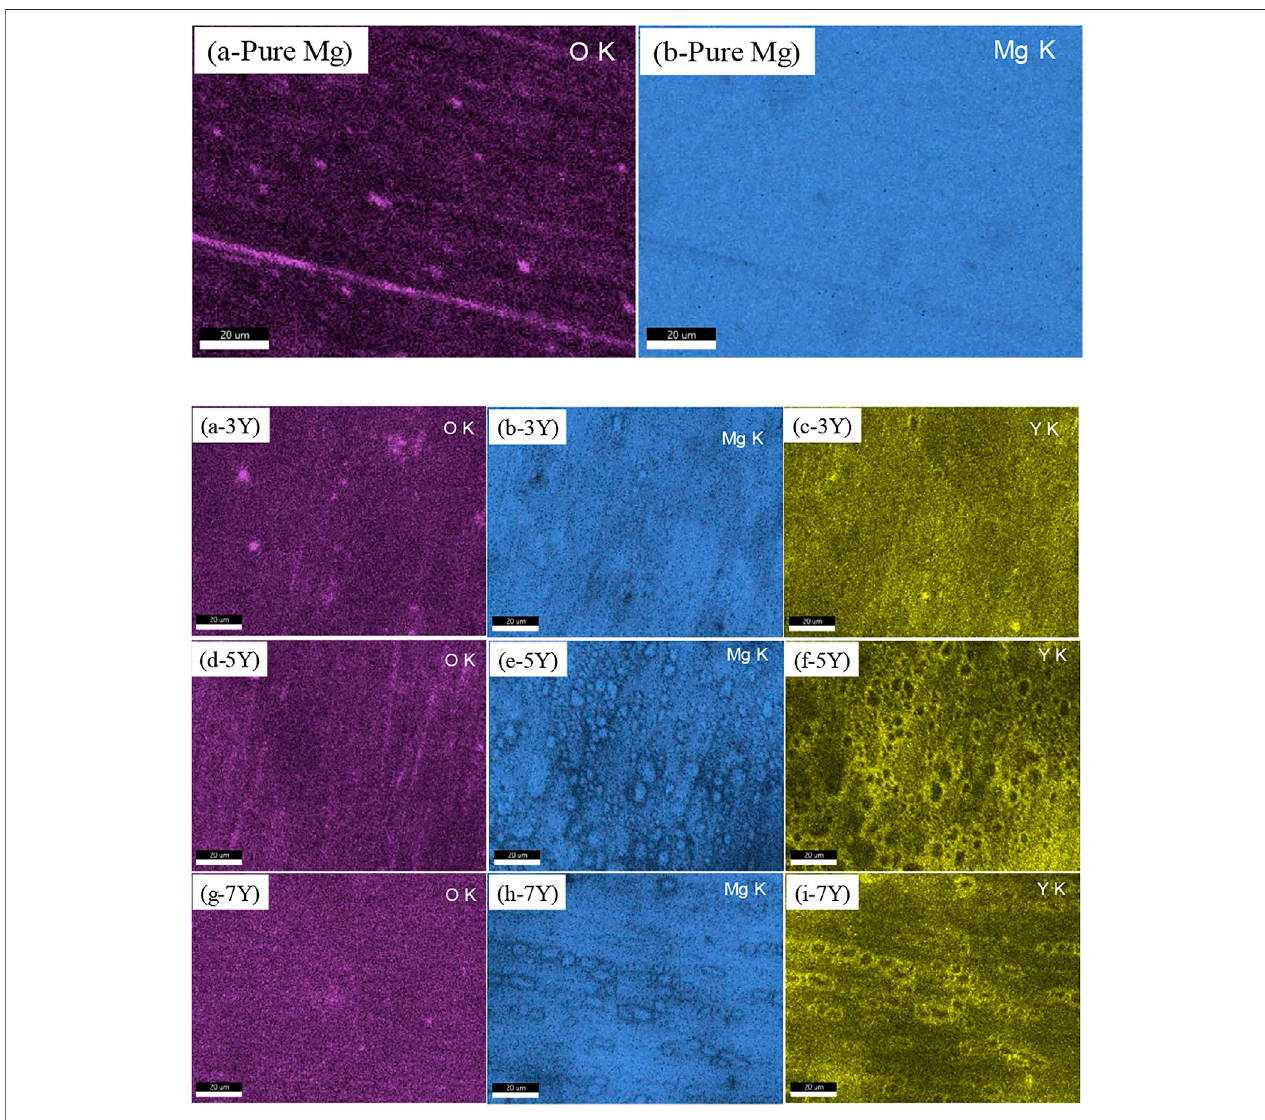
FIGURE3 | Themapping results ofelementary compositionin the oxidation products on different samples surfaces:(a-pure Mg) and (b-pure Mg):pure Mg; (a-3Y) and (b-3Y) and (c-3Y): Mg-3Y; (d-5Y) and (e--5Y) and (f-5Y): Mg-5Y; (g-7Y) and (h-7Y) and (i-7Y): Mg-7Y.